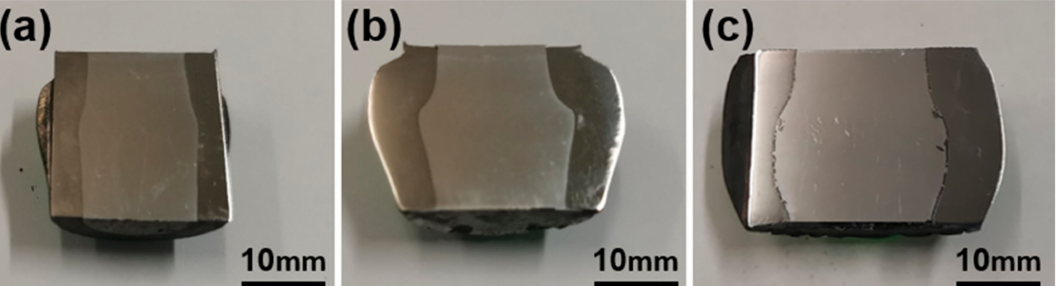
Figure 6. Vertical cross-section under different degrees of deformation: ( a ) 50%, ( b ) 70%, ( c )